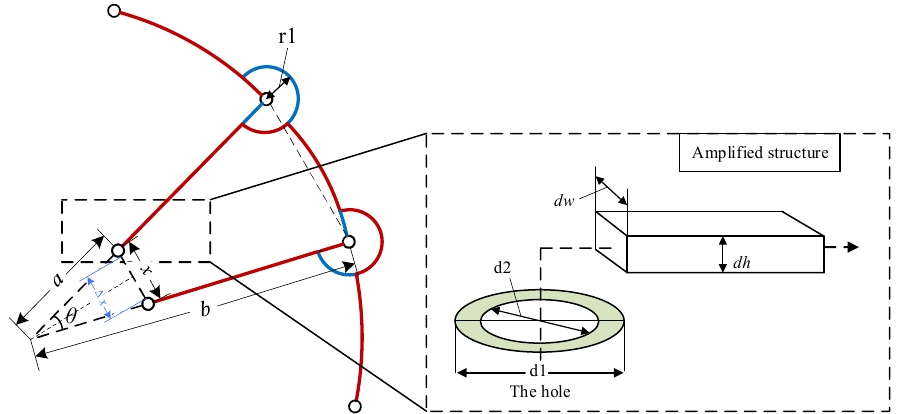
Figure 8. Size constraint relationship of the differential winding coil.